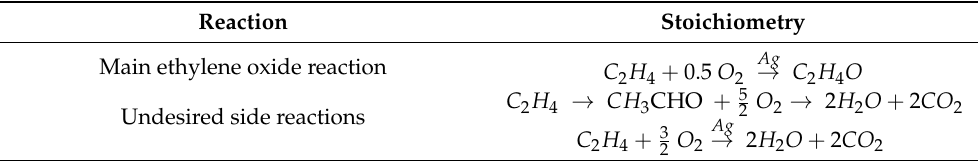
Table 10. Kinetic mechanism of usual ethylene oxide manufacture